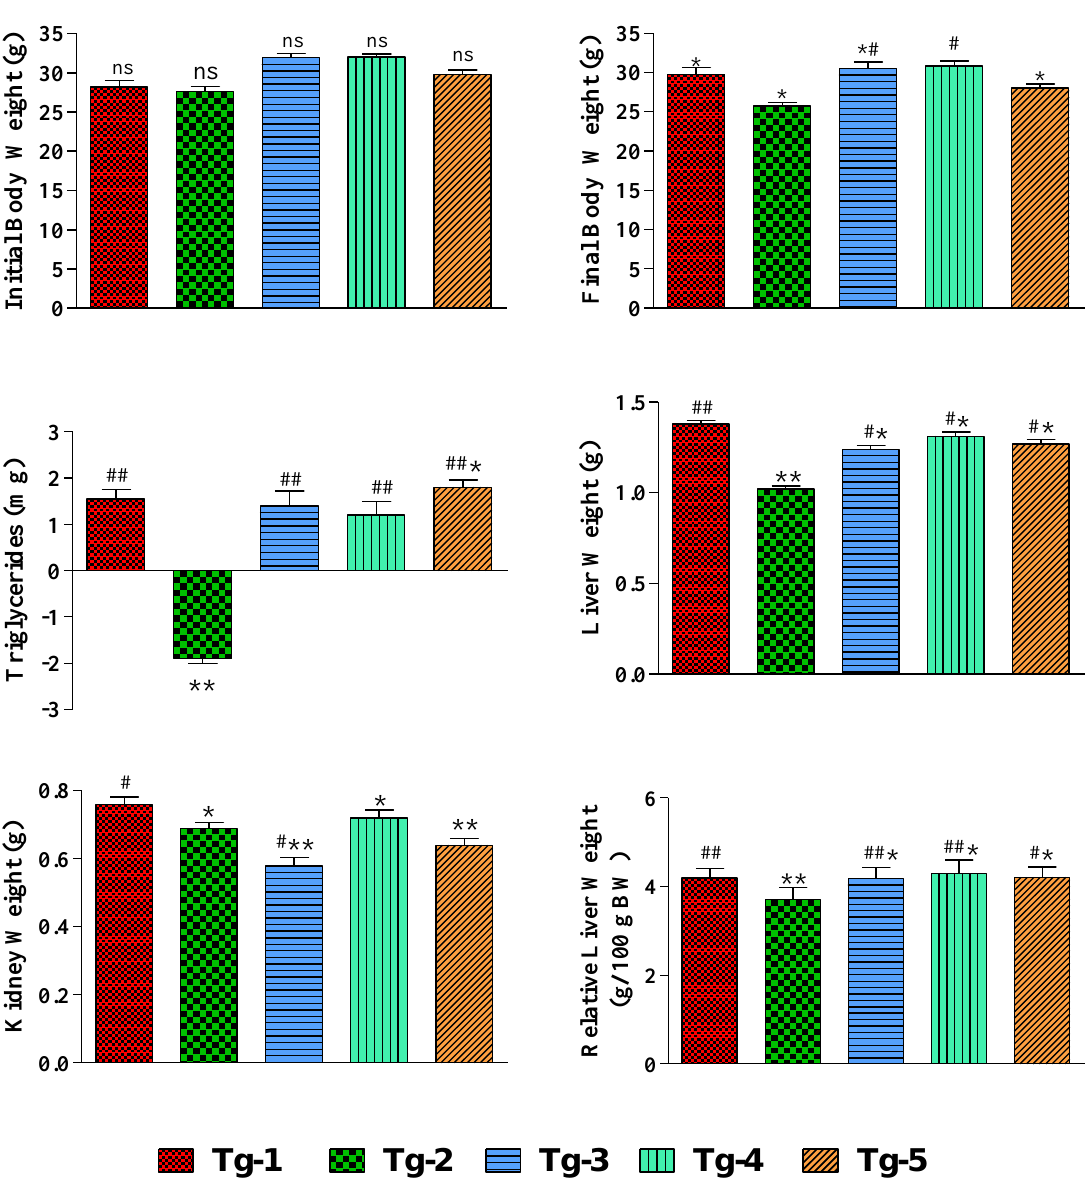
Figure 1. The organ weight and body weight in response to the treatment of the synthesized compound in diabetic mice. The results are presented as mean ± SE ( n = 3), ** p < 0.01; * p < 0.05; vs control group, # p < 0.05; ## p < 0.01 vs. STZ group. Metformin (MET) and streptozotocin (STZ). Tg-1 (control), Tg-2 (STZ), Tg-3 (compound 3 ), Tg-4 (STZ + metformin), and Tg-5 (STZ + compound 3 ).